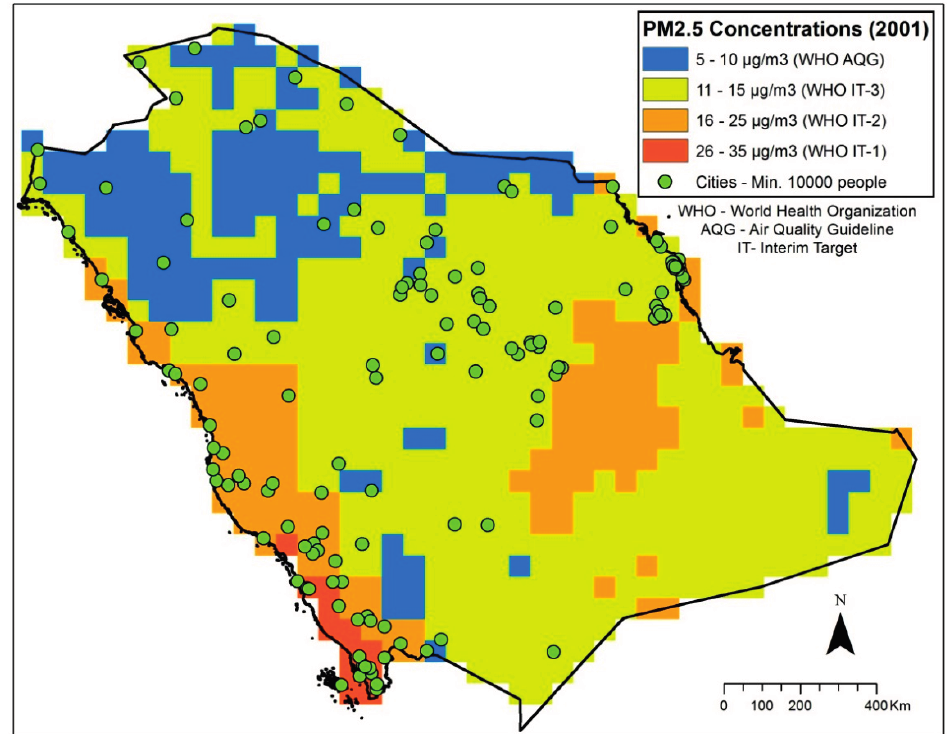
Figure 3. PM 2.5 concentrations (un-weighted) in